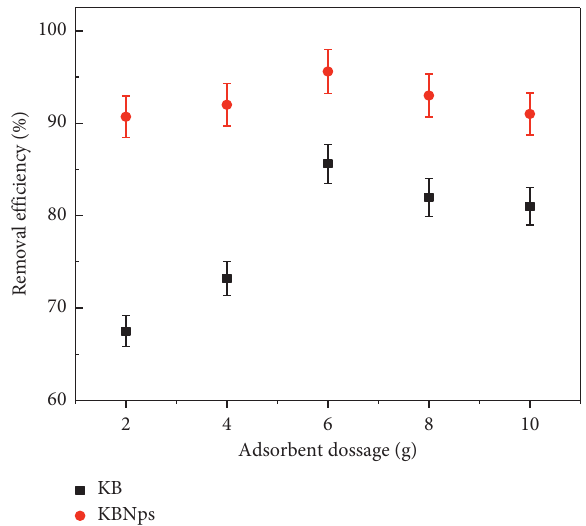
Figure 5: Effect of adsorbent dose on removal